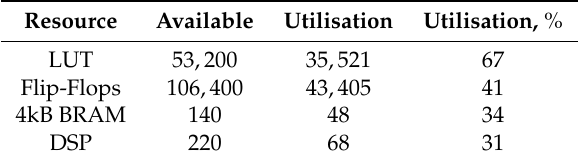
Table 2. Post-implementation report of the CNN core on Z-7020 FPGA.